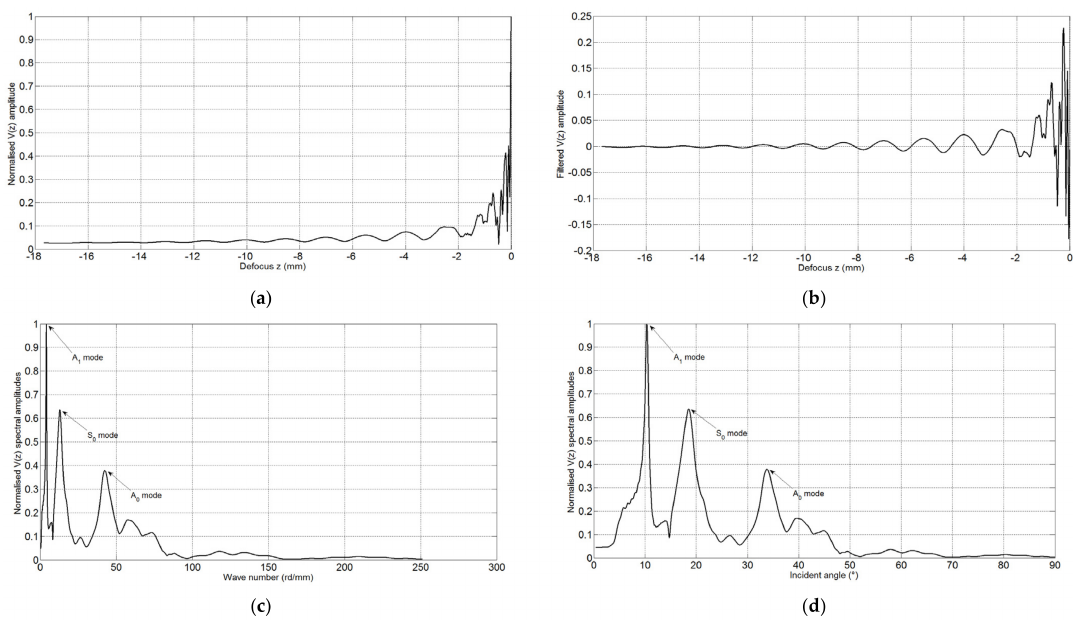
Figure 2. ( a ) Example of V ( z ) curve of an aluminum plate; ( b ) corresponding filtered V ( z ) curve; ( c ) spectral representation in the wave number space; ( d ) corresponding spectral representation in the incident angle